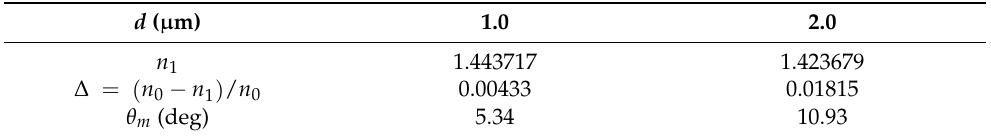
Figure 2. Effective RI of the inner cladding as a function of λ / Λ . Table 2. Effective RI of the cladding n 1 , relative RI difference ∆ = ( n 0 − n 1 ) / n 0 , where n 0 = 1.45, and the critical angle θ m for the varied air-hole diameter d at wavelength 850